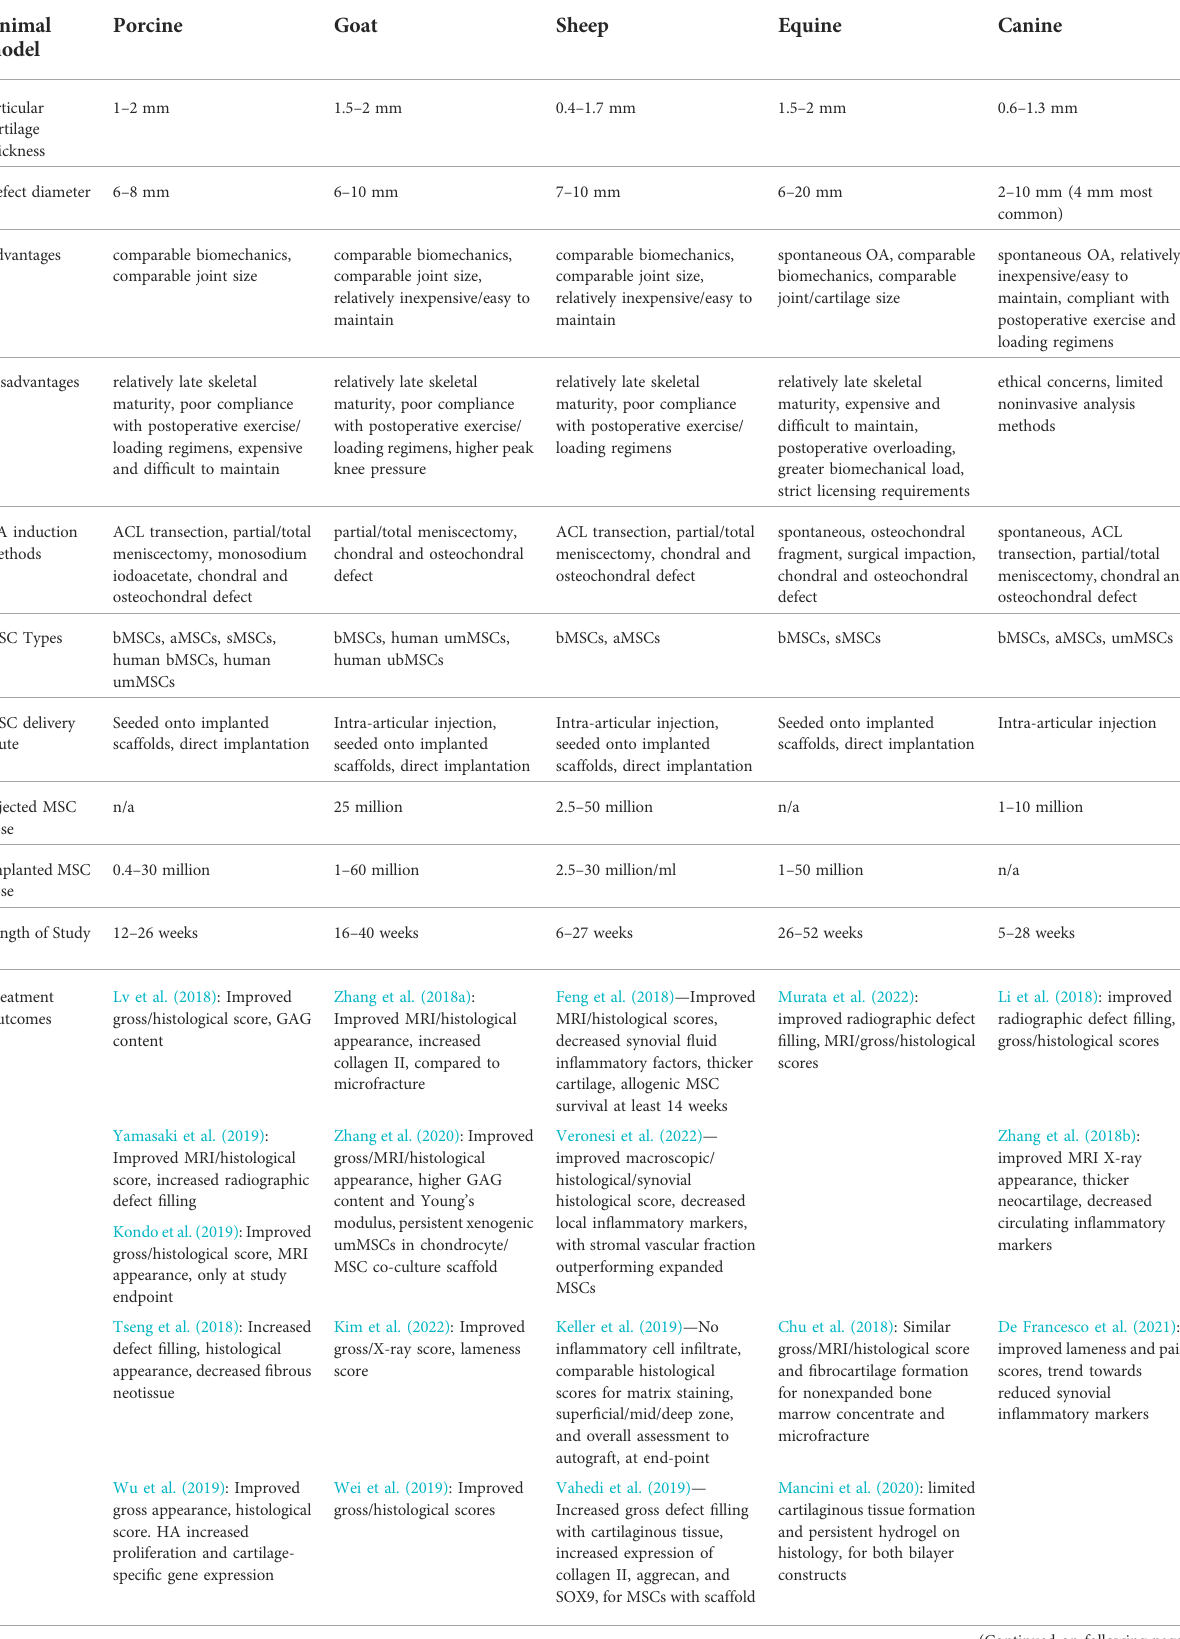
TABLE 1 Advantages, disadvantages, and logistics of large animal models for articular cartilage injury and regeneration with MSC treatment, with parameters of relevant studies published within the last 5 years. Animal